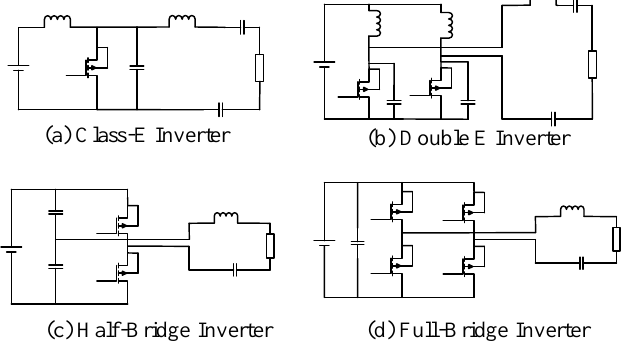
Figure 6. Circuit structures of high-frequency inverters.